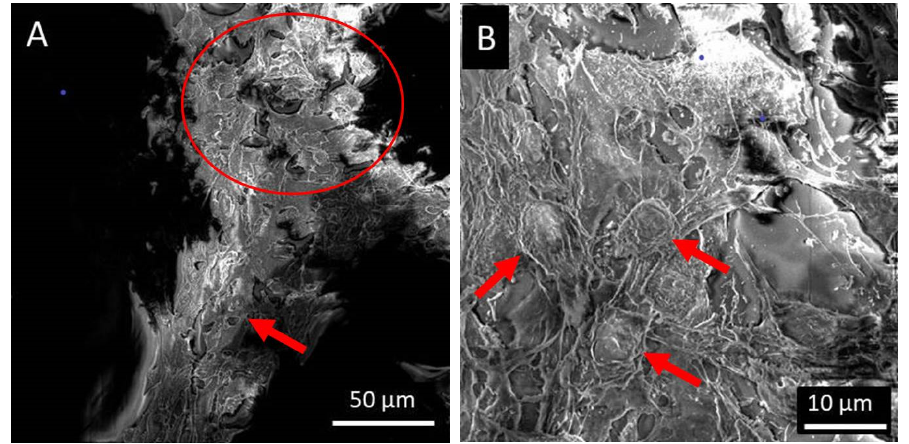
around the PLA or silk fibroin and gelatin-coated PLA micro filament surfaces. On top of the fiber surfaces, the LSCs showed flat or elongated morphologies (Figure 7A,C,E), while side views of the filaments also revealed somewhat 3D or spherical structures (Figure 7B,D,F).